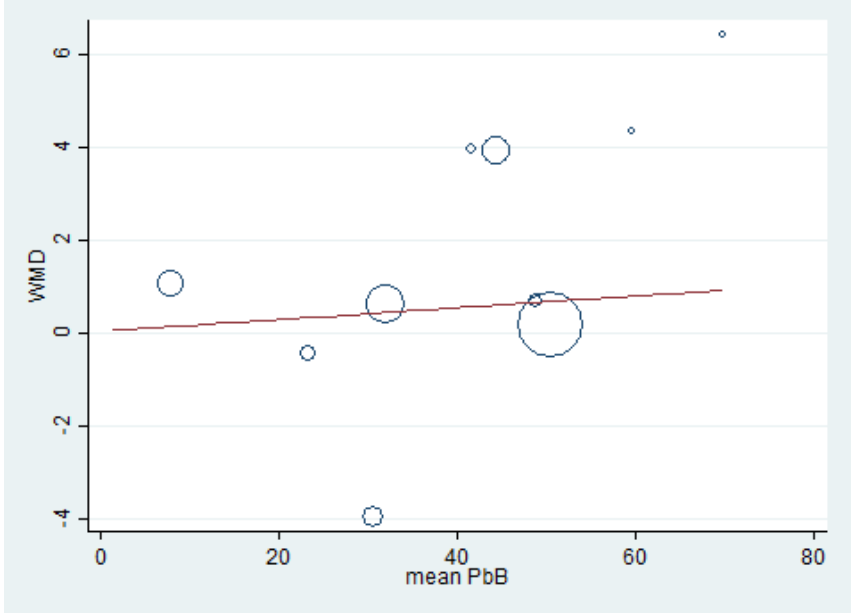
Figure 9. Meta-regression analysis of WMD and the BUN/creatinine ratio. WMD: Weighted Mean Difference, BUN: Blood Urea Nitrogen (mg/dL), PbB: Blood Lead ( µ g/dL).